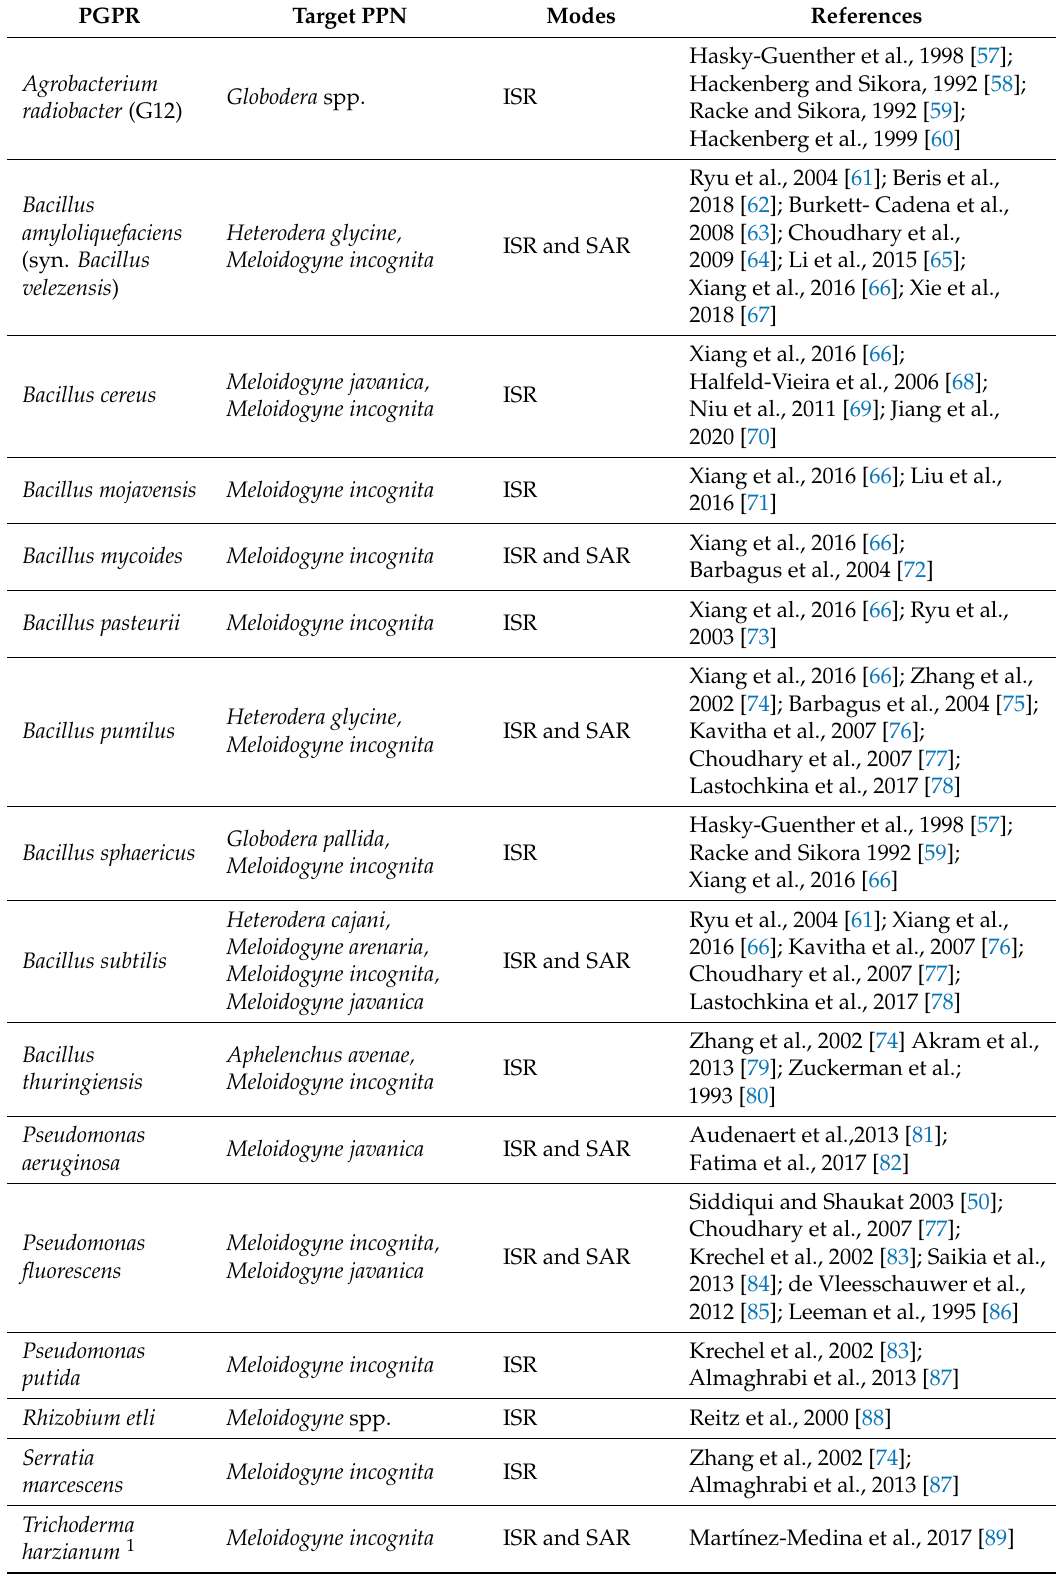
Table 2. A list of PGPR conferring indirect antagonisms against